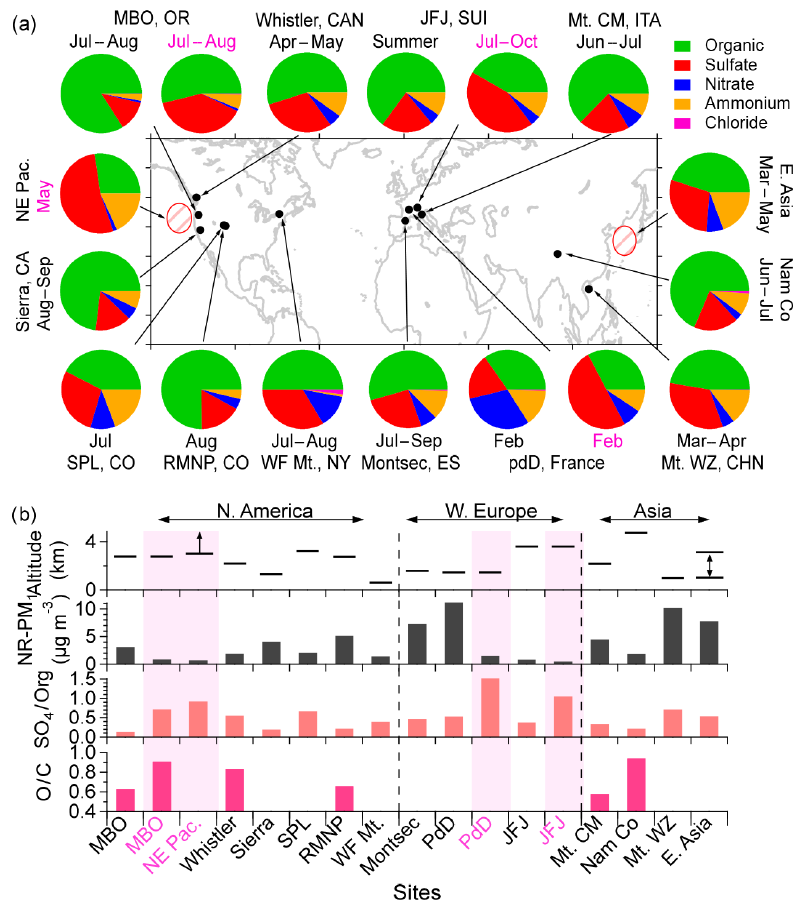
Figure 6. (a) Location of selected high-altitude mountain sites and aircraft measurements of regional background aerosols in the world and the chemical composition of NR-PM 1 (details are listed in Table S1 in the Supplement). Pie charts show the average chemical composition of NR-PM 1 . (b) Sampling altitude, average NR-PM 1 mass concentration, sulfate-to-organic mass ratio (SO 4 / Org), and average O / C ratio of OA determined using the Aiken-Ambient method for each site. The sampling period labels for pie charts in (a) and the bottom axis labels for sites in (b) are colored according to air mass types: mixed BL–FT air (black) and FT air only (pink). Shaded pink bars in (b) highlight the FT